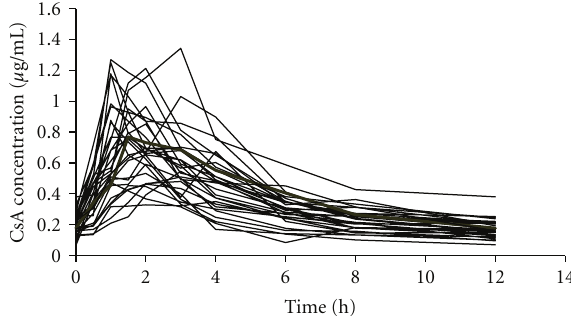
Figure 1: Individual blood concentration-time curves of patients administered CsA ( n =